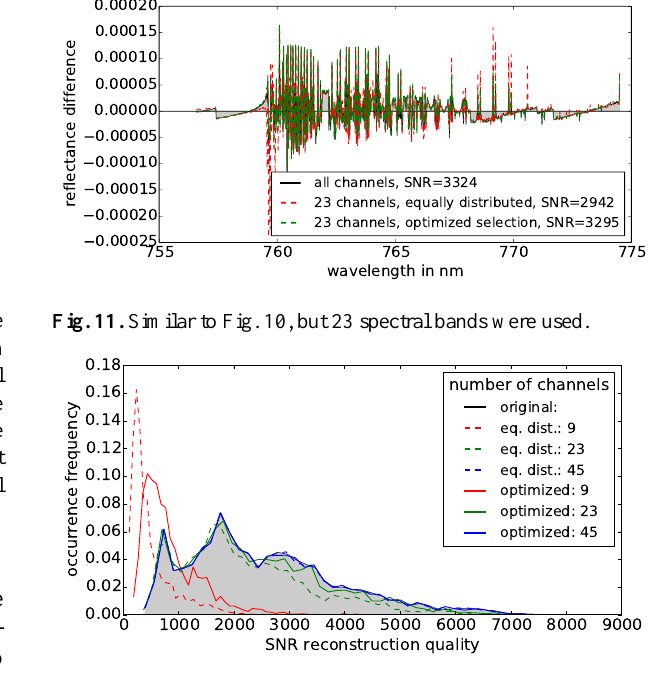
29 Fig. 12. The grey area shows the reconstruction SNR histograms for the original (i.e., using the full spectral information) reconstruc- 28 tion and two of the discussed reconstruction techniques using small spectral subsamples. The dashed lines show results for the equal sampling technique, while the lines show results for the selection based on the minimization of C matrix residuals. The colors indi- cate the different size of the spectral